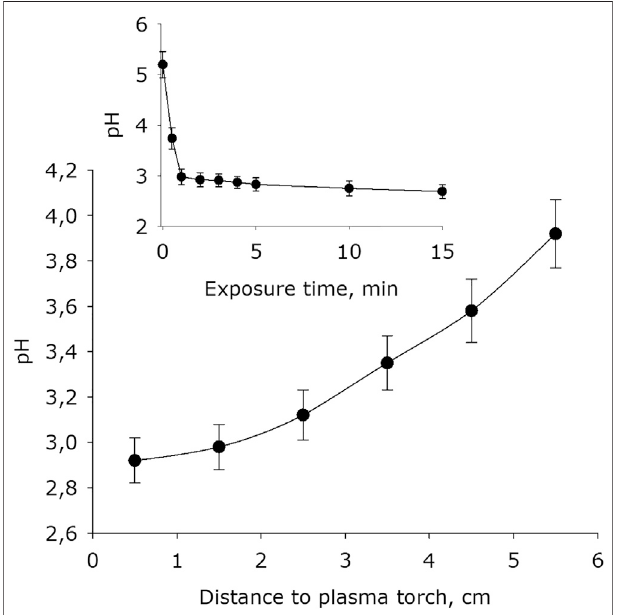
FIGURE 6 | The water pH-index dependence on distance from water surface to the plasma jet nozzle at 1 min of plasma exposure. Data are presented as mean standard error for three independent experiments. Inset shows thewaterpH-index depending onthetimeofplasmaexposureat 1.5 cm distance from water surface to the plasma jet nozzle. The data are presented as average values with standard deviation of three experiment repetitions.